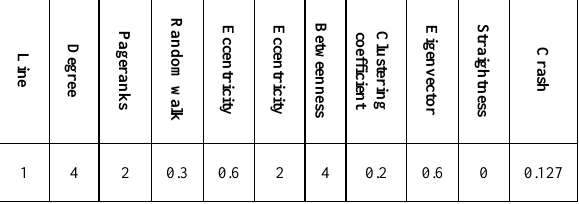
Table 2. A sample of the training data criteria